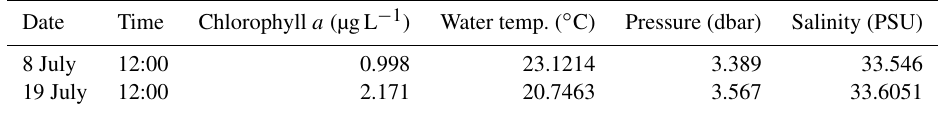
Table 2. Seawater conditions at the time of